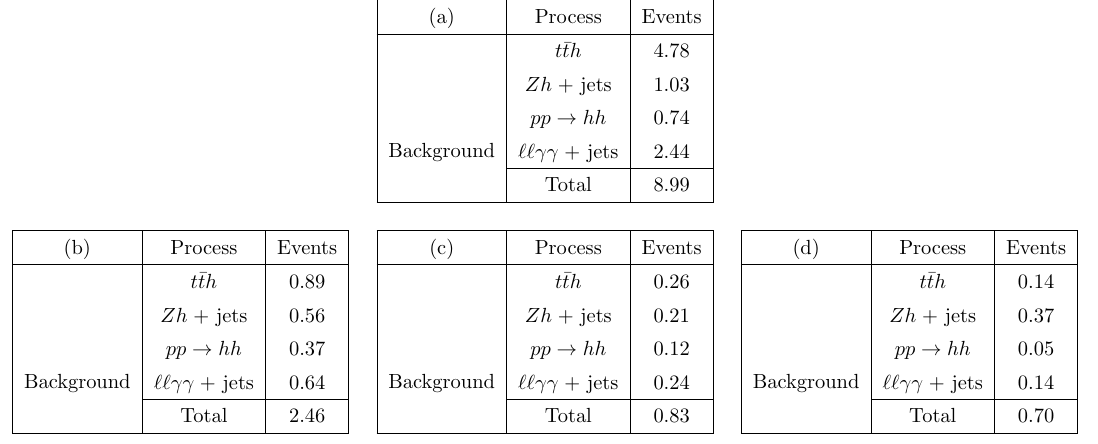
Table 14 . Respective background yields for the (cid:13)(cid:13) 2 ‘ + =E T channel after the BDT analyses opti- mised for m H = ( a ) 400 GeV, ( b ) 600 GeV, ( c ) 800 GeV and ( d ) 1 TeV. The various perturbative orders for the backgrounds are the same as in table